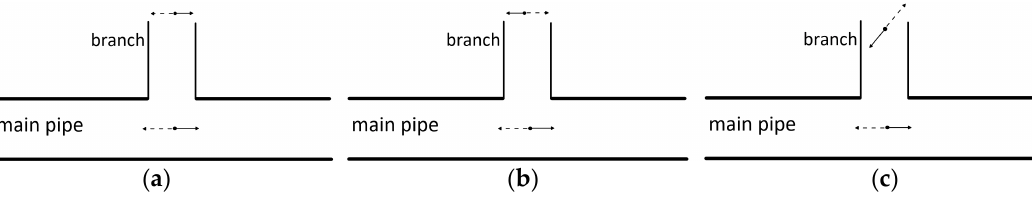
Figure 2. Vibration of the pipe and branch: ( a ) in-phase in the same direction (without the relative deflection) ( b ) out p-hase in the same direction (inducing deflection of branch), and ( c ) in a different direction (inducing deflection of the branch).